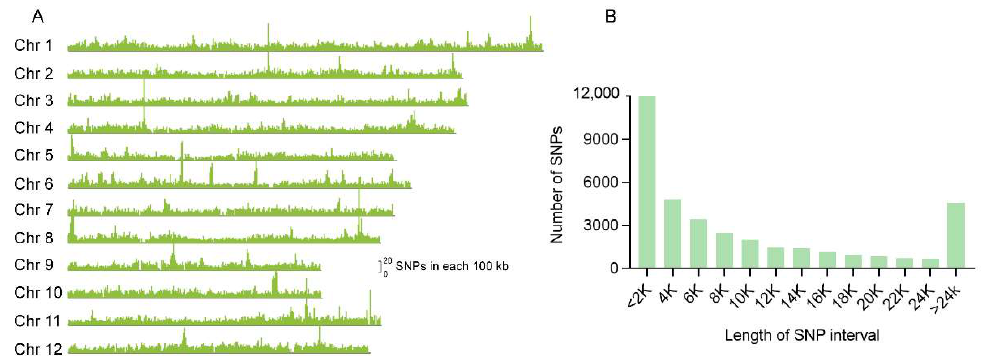
Figure 1. Characteristics of the SNPs used for array establishment in the whole genome of rice. ( A ) Distribution of SNPs along the 12 chromosomes. The height of the peaks indicates the numbers of each 100 kb region. ( B ) The frequency distribution diagram for the distance between the SNPs.